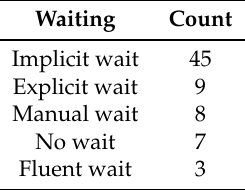
Table A5. 2.c. What wait strategy do you implement in your Selenium tests?